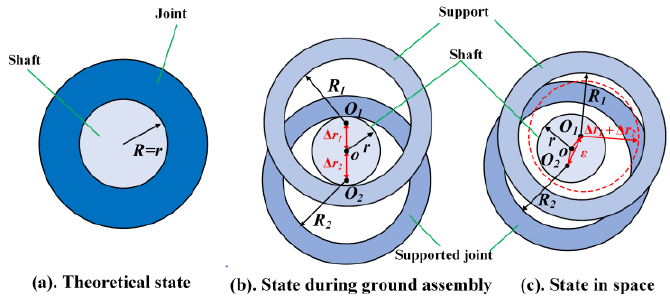
Figure 8. Illustrations of the different states of an assembled hinge.